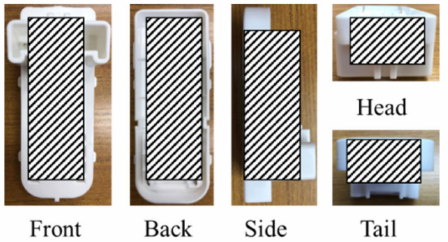
Figure 7. Five classes depending on the product surface.